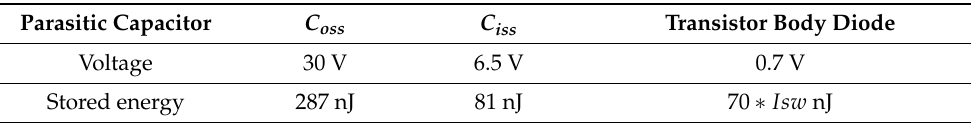
Table 3. Energies lost at each commutation due to C oss , C iss and body diode